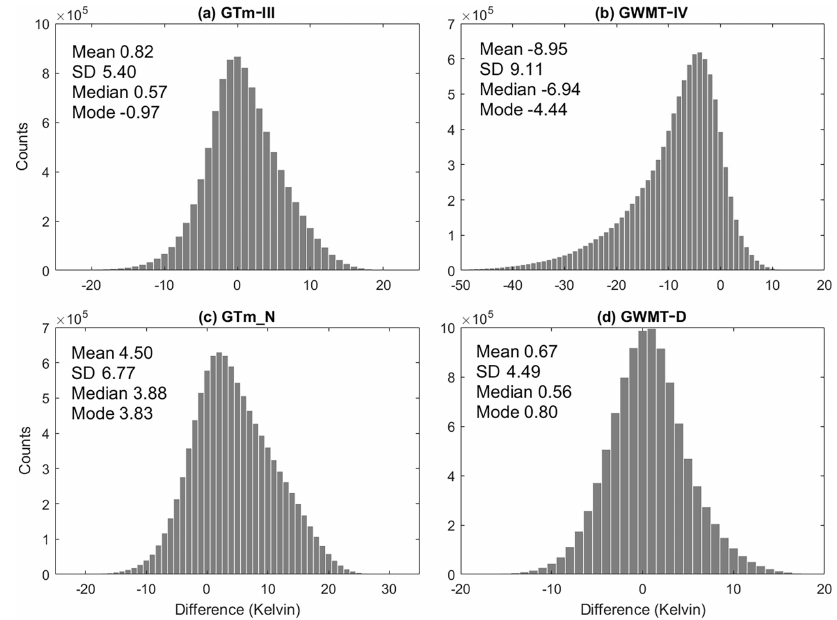
Figure 9. Histogram of model-derived T m minus radiosonde-derived T m in 2014 at different heights.